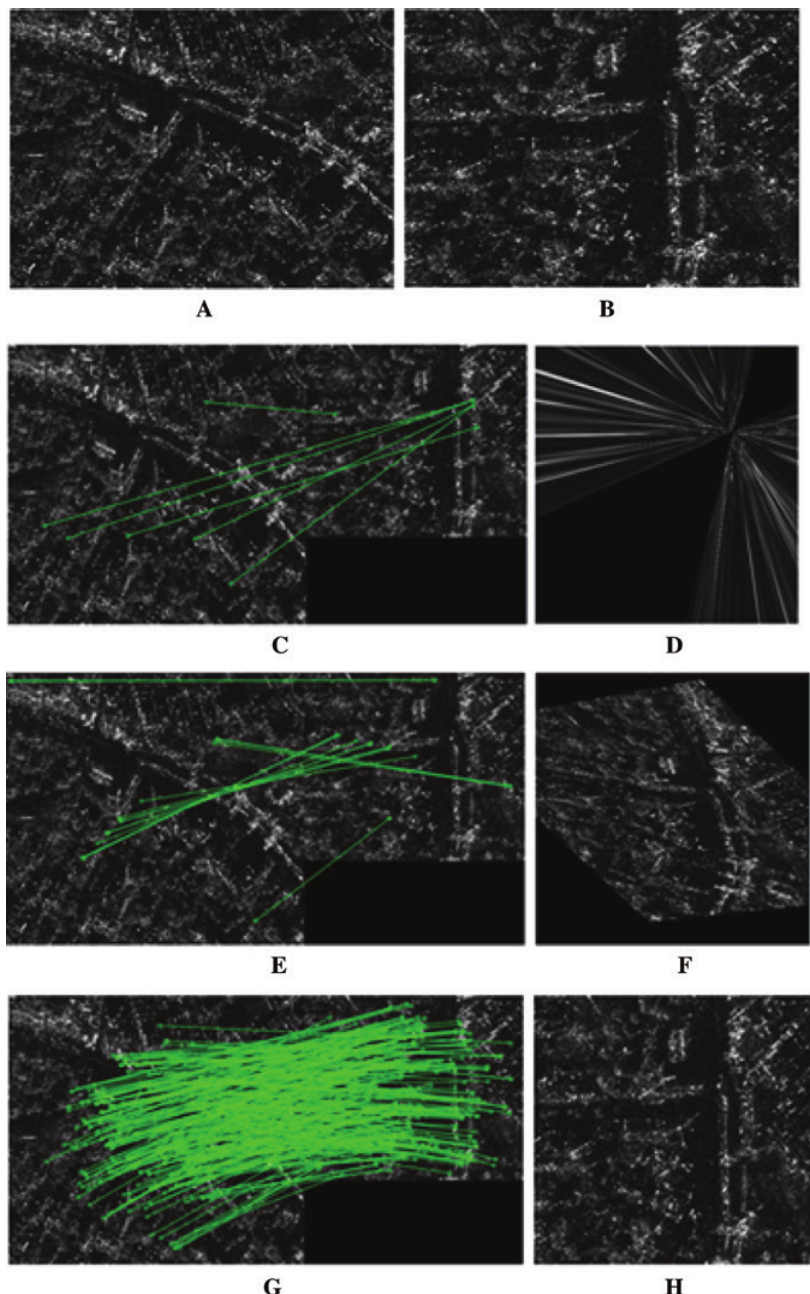
Figure 8: Dataset 1. (A) Dataset 1 – source SAR image; (B) dataset 1 – 60 ° rotated target image; (C, E, G) number of correspondences obtained using FIA, ASIFT, and AIAVS; and (D, F, H) output aligned images using FIA, ASIFT, and AIAVS. of correspondences obtained using FIA, ASIFT, and AIAVS (C, E, G); and the aligned or transformed output image using FIA, ASIFT, and AIAVS (D, F, H). Figure 9 shows dataset 2 – source SAR image (A); dataset 2 – scale deformed target image (B); the number of correspondences obtained using FIA, ASIFT, and AIAVS (C, E, G); and the output aligned images using FIA, ASIFT, and AIAVS (D, F, H). It is observed from Figures 8 and